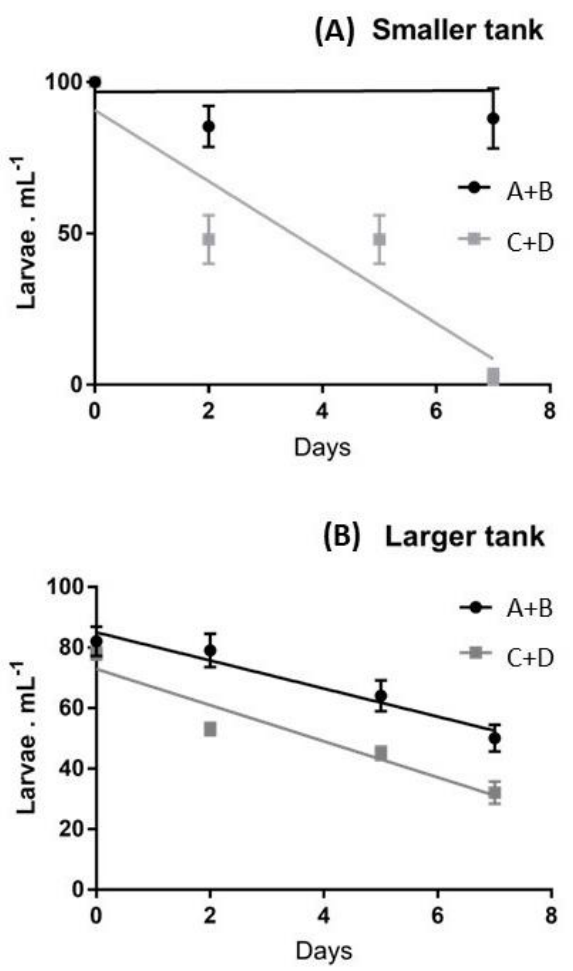
Figure 2. Average larval survival rates evaluated during the first week in ( A ) smaller and ( B ) larger- tanks, referring to the recruits of females A+B vs. those of females C+D. The linear regressions are superimposed.